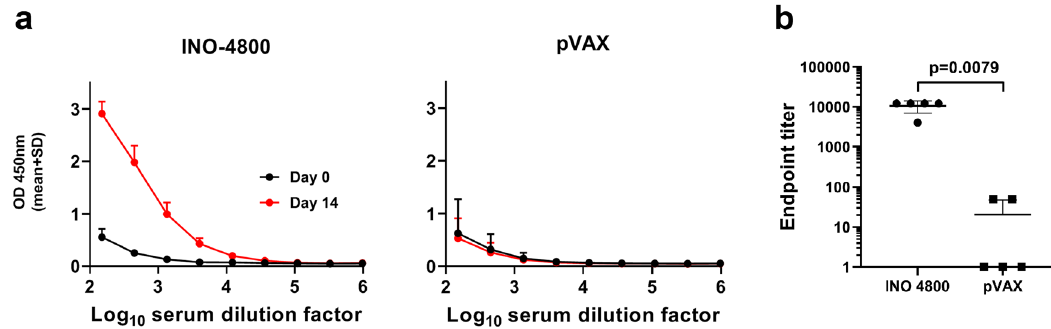
Fig. 5 Humoral responses to SARS-CoV-2 in Hartley guinea pigs after a single dose of INO-4800. Hartley guinea pigs were immunized on Day 0 with 100 µ g INO-4800 or pVAX-empty vector as described in the methods. a SARS-CoV-2 S protein antigen binding of IgG in serial serum dilutions at day 0 and 14. Data shown represent mean OD450 nm values (mean + SD) for the fi ve guinea pigs. b Serum IgG binding titers (mean ± SD) to SARS-CoV-2 S protein at day 14. Values depicted are mean ± SD. P values determined by Mann – Whitney test.